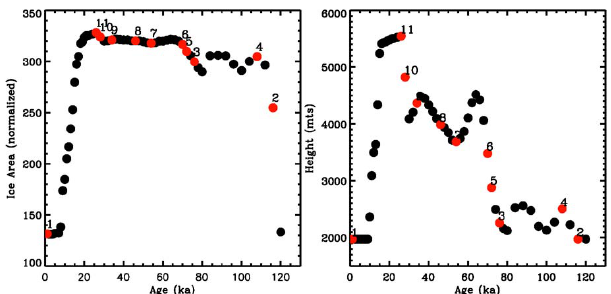
Figure 1. Left panel: ice area, in normalized units, and maximum height (in meters) in the region 45–75 ◦ N and 240–275 ◦ W (Lau- rentide Ice Sheet), as a function of time in the boundary conditions used in the Singarayer and Valdes (2010) experiment. Right panel: Height (in meters) of the ice sheets. This shows that, although the volume of the ice masses is quite different, their area is not. Red circles indicate the boundary conditions used for this specific